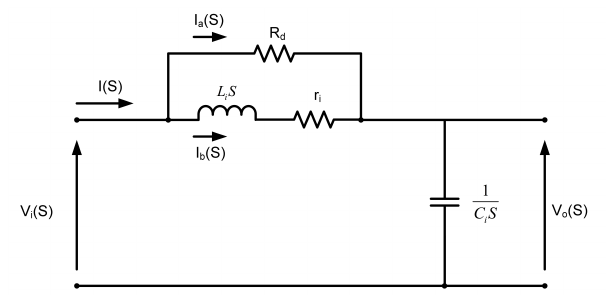
Figure 3. Diagram to calculate the transfer function of the input filter in the S